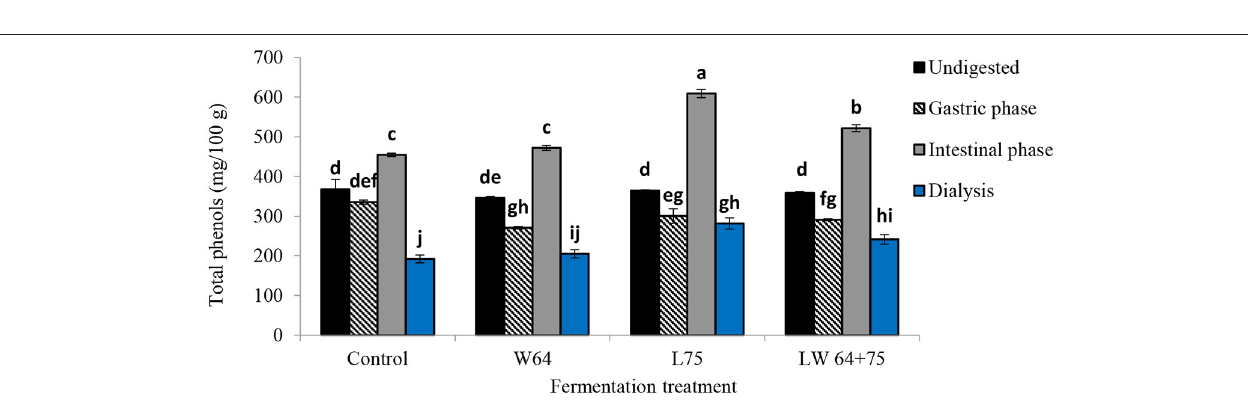
FIGURE 7 | Total polyphenol content of LAB fermented smoothies subjected to simulated in vitro gastrointestinal digestion. Bars with similar alphabetic letters for a specific digestive phase are not significantly different at p < 0.001 level. W64, Weissella cibaria 64; L75, Lactobacillus plantarum 75; LW64 + 75, W. cibaria 64 + L. plantarum 75. DW, dry weight; control, non-fermented